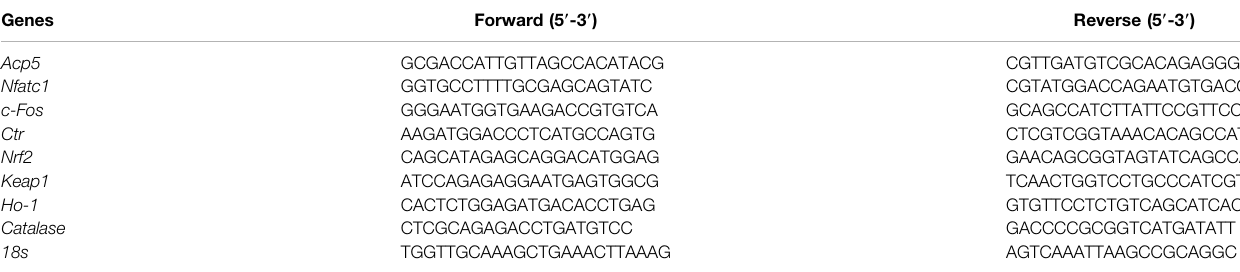
TABLE 1 | Quantitative real-time PCR primer